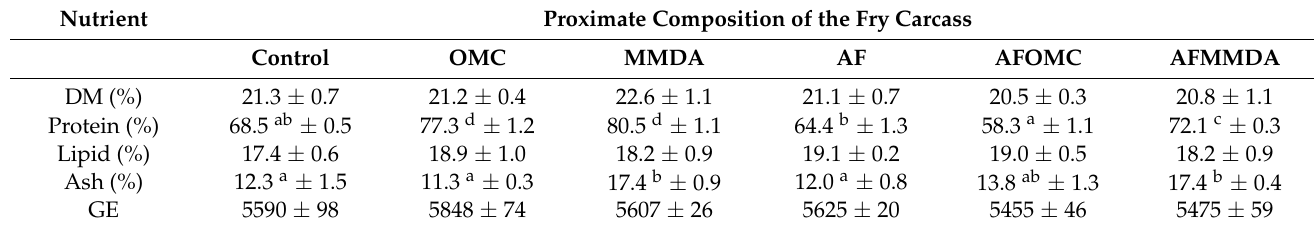
Table 3. Carcass composition (% on dry weight basis) of the fry.